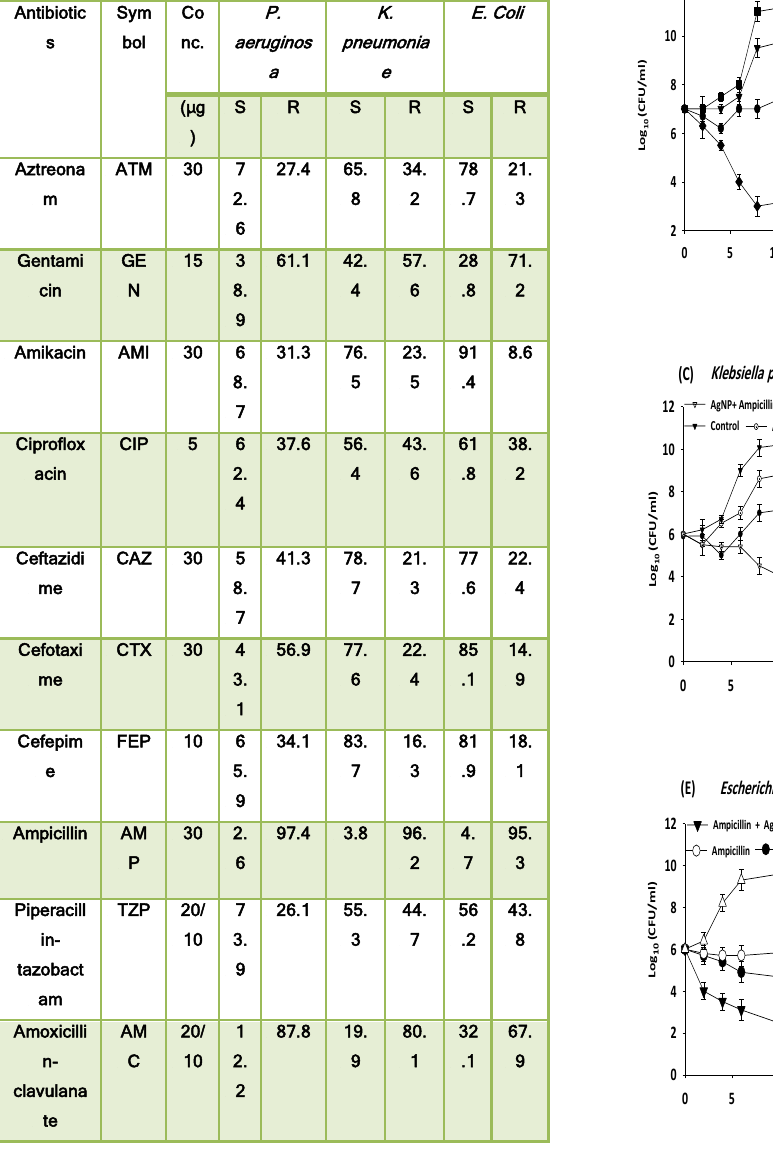
Antibiotic susceptibility test of Gram-negative bacilli isolated from burn wound infections